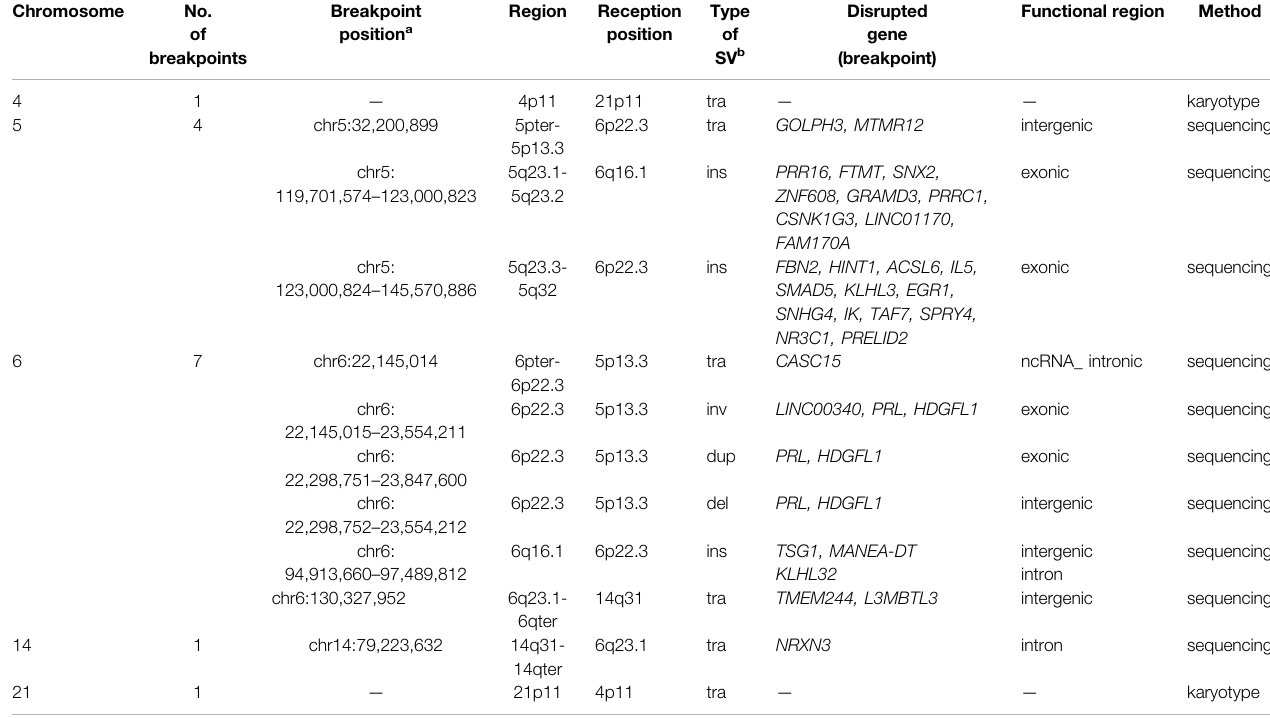
TABLE 2 | Details of the breakpoints in the current study. Chromosome No.